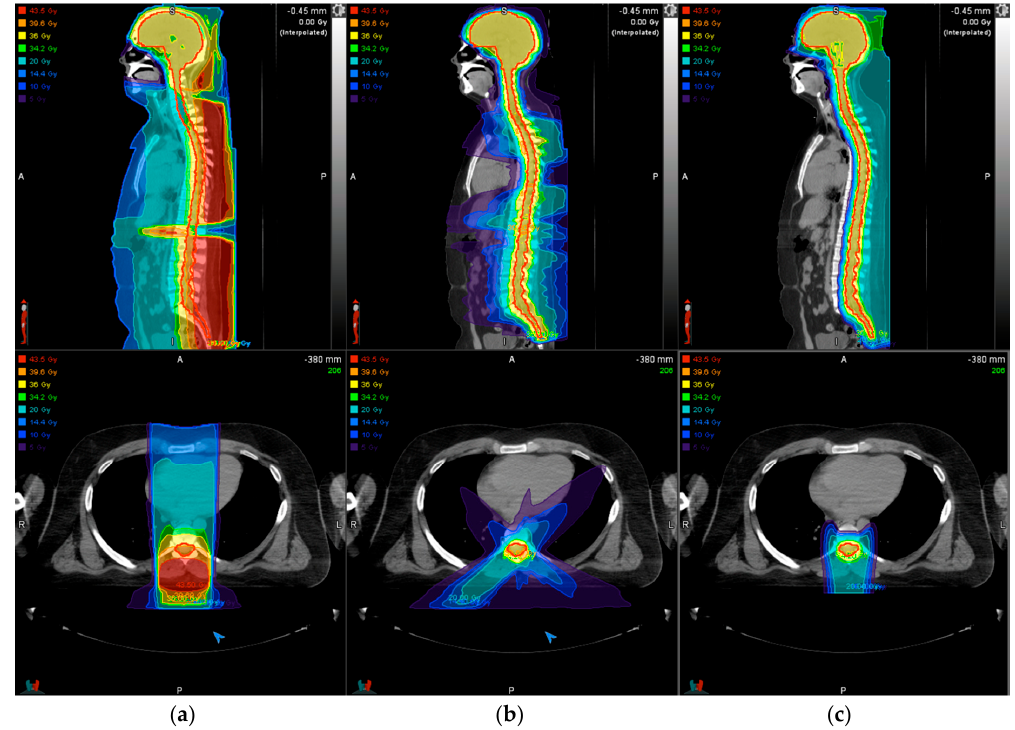
Figure 2. Comparison of dose distributions for a patient undergoing craniospinal irradiation to a dose of 36 Gy by three-dimensional conformal radiation therapy (3DCRT) ( a ), intensity modulated radiation therapy (IMRT) ( b ), or proton beam radiation therapy (PBRT) ( c ). Each pane shows the dose distribution in sagittal (top) and transverse (bottom) views. The target volume is indicated by the thick red line that encompasses the brain and spinal canal down to the thecal sac. Prescription dose (shaded yellow) and target coverage are similar across modalities, but higher entrance (posterior) dose is seen in the 3DCRT plan in comparison with IMRT or PBRT. The abdomen receives more low-dose radiation (shaded green, blue, and purple) using photon modalities compared with PBRT. Inverse planning through IMRT or VMAT, however, allows for coverage of irregularly shaped targets by specifying the radiation prescription dose and coverage up front as well as dose limits for normal tissues. These are collectively referred to as treatment objectives. IMRT is achieved through modulating the intensity of the radiation beam during treatment delivery. In contrast to fixed-field or “step and shoot” IMRT, whereby radiation is delivered at (five to nine) fixed beam positions, VMAT delivers IMRT by modulating the intensity of the radiation beam continuously during treatment while the machine rotates around the patient and thereby shortens the treatment time. Treatment objectives are turned over to a computerized optimization algorithm that generates a plan that optimizes the radiation dose distribution relative to the treatment objectives. The advantage of these approaches to photon RT compared with 3DCRT is exquisite customization of the radiation dose distribution given any patient’s anatomy using equipment that is widely available. The disadvantages, however, are that treatment planning takes significantly longer (anywhere from one to two weeks) and that a low dose of radiation to a greater volume of normal tissues occurs (Figure